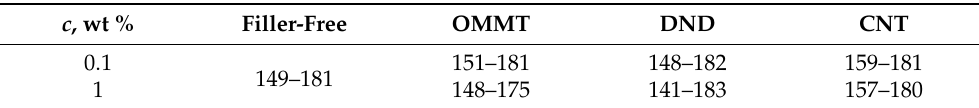
Table 2. Temperature interval of the glass–rubber transition of carbon-fiber-reinforced epoxy plastics containing nanoparticles (in ◦ C).